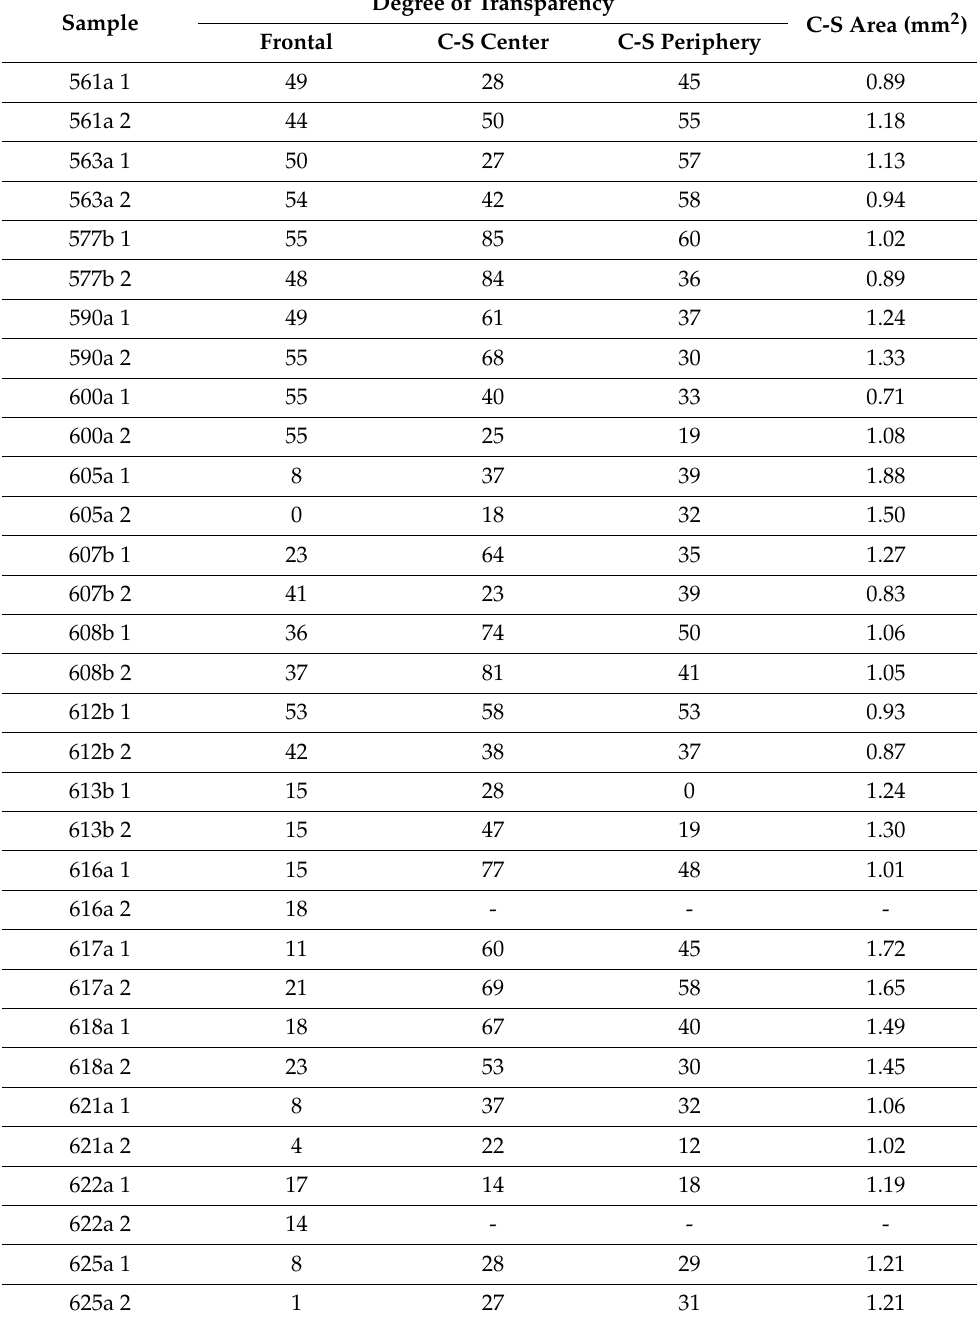
Table 1. Degrees of transparency, observed frontally and in the cross-section (C-S), both at the periphery and the center and the different area sizes of each sample cross section. Samples 616a2 and 622a2 C-S omitted due to damage when cutting. The degrees of transparency range from 100 = Black/transparent to 0 =